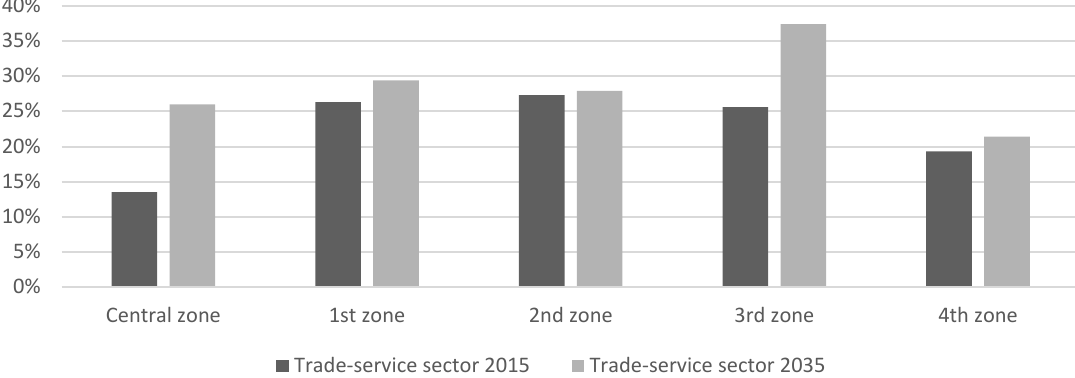
Figure 5. Forecast of the share of trade-service sector in the economic structure of Ekaterinburg